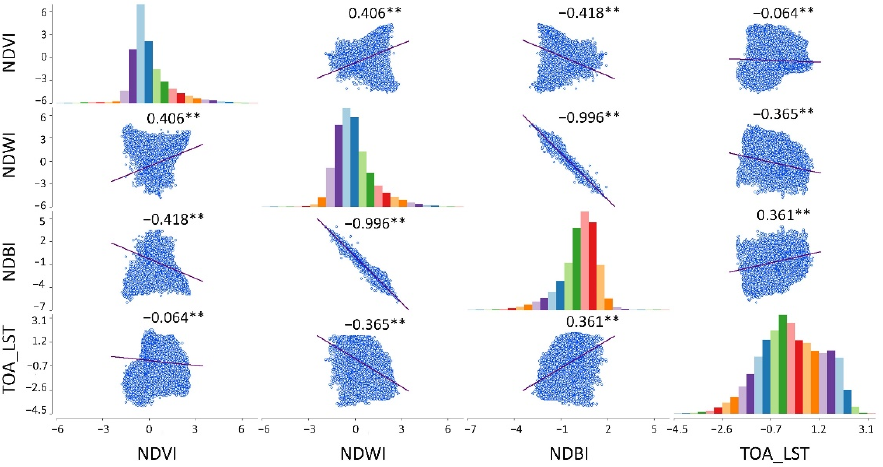
Figure 9. Relationship between LST and spectral indices with their corresponding slope of linear fit and frequency distribution chart. ** significant at 𝑝 < 0.01 .